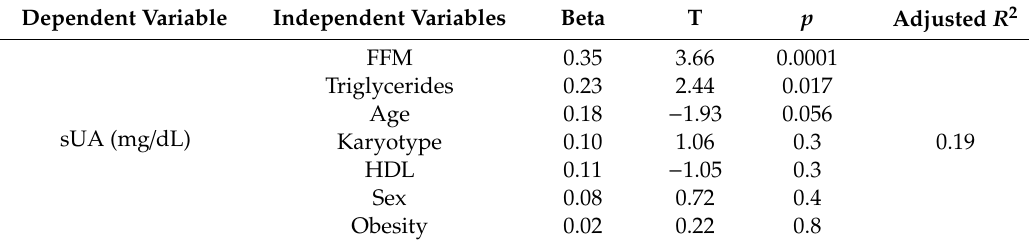
Table 3. Stepwise multivariable regression analysis in the PWS group. sUA was tested as the dependent (continuous) variable. Independent variables tested in the equation were age (year), sex (females = 0, males = 1), obesity (BMI > 30 kg / m 2 ), PWS karyotype (DEL15 = 0, UPD15 = 1), fat-free mass (FFM, kg), triglycerides (mg / dL), and HDL-cholesterol (mg / dL) levels. Dependent Variable